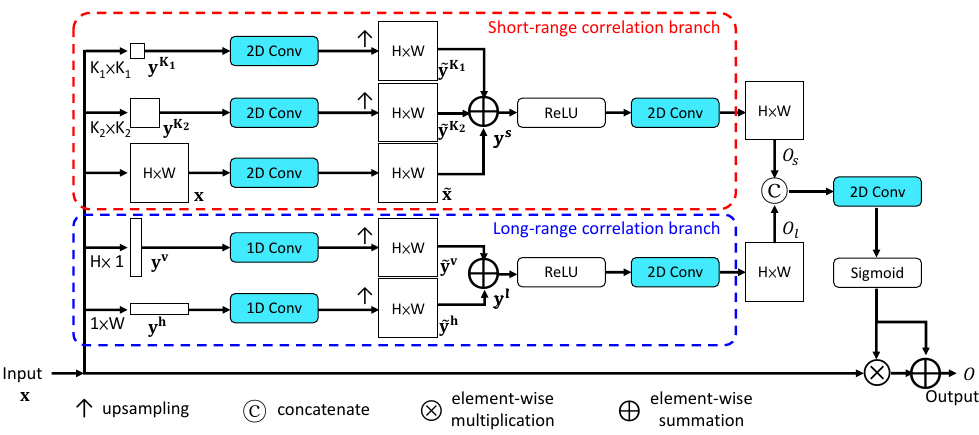
Figure 3. The Mixed Pooling Module (MPM)